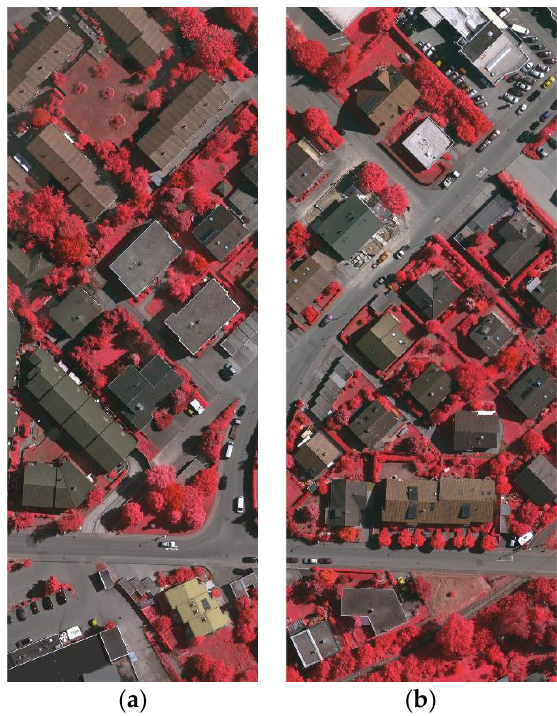
Figure 9. The area of the experiment data is selected: ( a ) the training data is selected on the left side of Area 30; and ( b ) the test data is selected on the right side of zone 30. Table 4. Different proportions of extraction results.